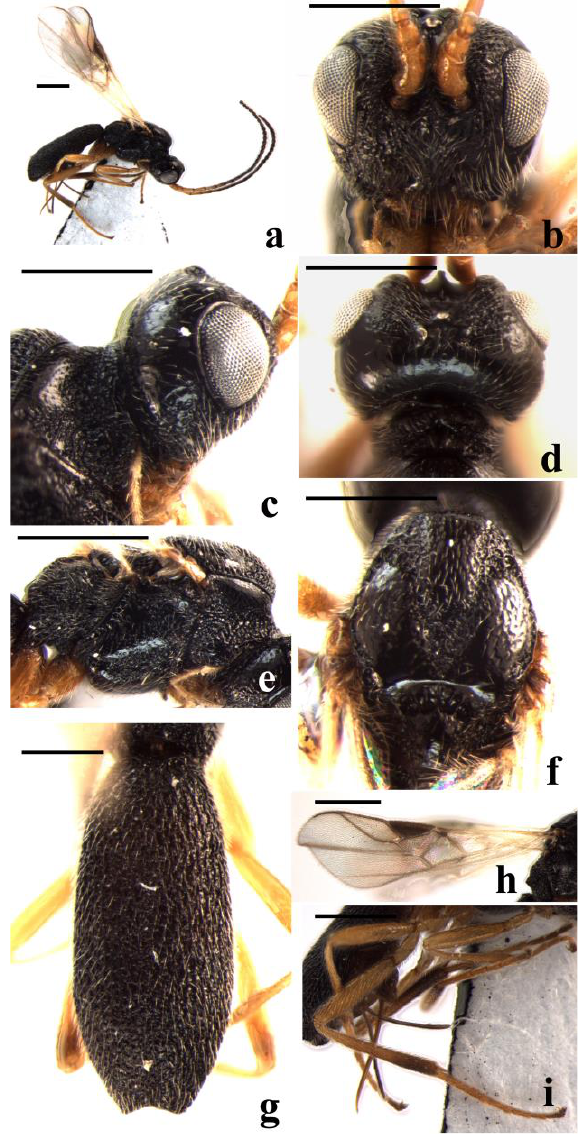
Figure 3. Schizoprymnus liui sp. nov., holotype, ♀ . ( a ) Habitus, lateral aspect; ( b ) head, frontal aspect; ( c ) head, lateral aspect; ( d ) head, dorsal aspect; ( e ) mesosoma, lateral aspect; ( f ) mesoscutum, dorsal aspect; ( g ) carapace, dorsal aspect; ( h ) fore wing; ( i ) hind leg, lateral aspect. Scale bar: 1 mm. Description . Female. Body length (excluding ovipositor sheath) 3.2 mm; length of the extended part of the ovipositor sheath 0.8 mm; fore wing length 2.8 mm. Head. Antennomeres 30, length of the third antennomere is 0.9 times the fourth an- tennomere; the length of the third, fourth, and penultimate antennomeres are 3.2, 3.4, and 1.0 times their width, respectively; length of the maxillary palp is 0.8 times the height of the head; POL: OD: OOL = 9: 5: 15; occipital carina is complete, distinct, and arched medio- dorsally; frons is distinctly concave and punctate medially and with a strongly protruding lamella, laterally, tuberculate, reticulate-rugose; in dorsal view, length of eye almost equal to length of temple; vertex sparsely punctate and shiny, with a weakly longitudinal groove; temple sparsely punctate and shiny, reticulate-punctate near mandible; face ru- gose-reticulate, medially with a medio-longitudinal carina; malar suture is present; clyp- eus is convex and punctate, its ventral margin truncate; length of the Malar space is 2.3 times the basal width of the mandible; tentorial pits are distinct, and the distance between the pits is 0.5 times the distance from pit to eye.